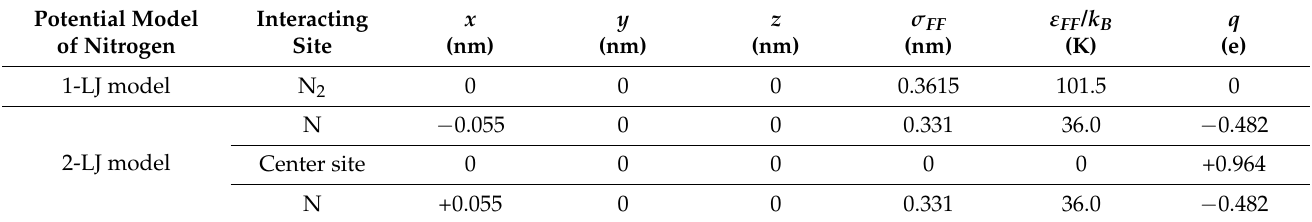
Table 2. Molecular parameters of nitrogen used in this work.